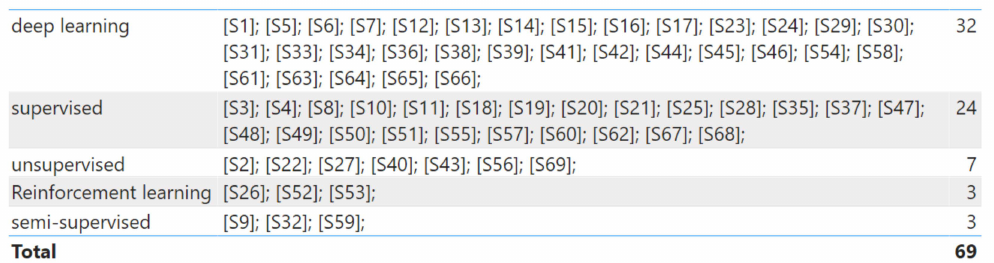
Figure 8. List of papers classified by the machine learning techniques utilized in